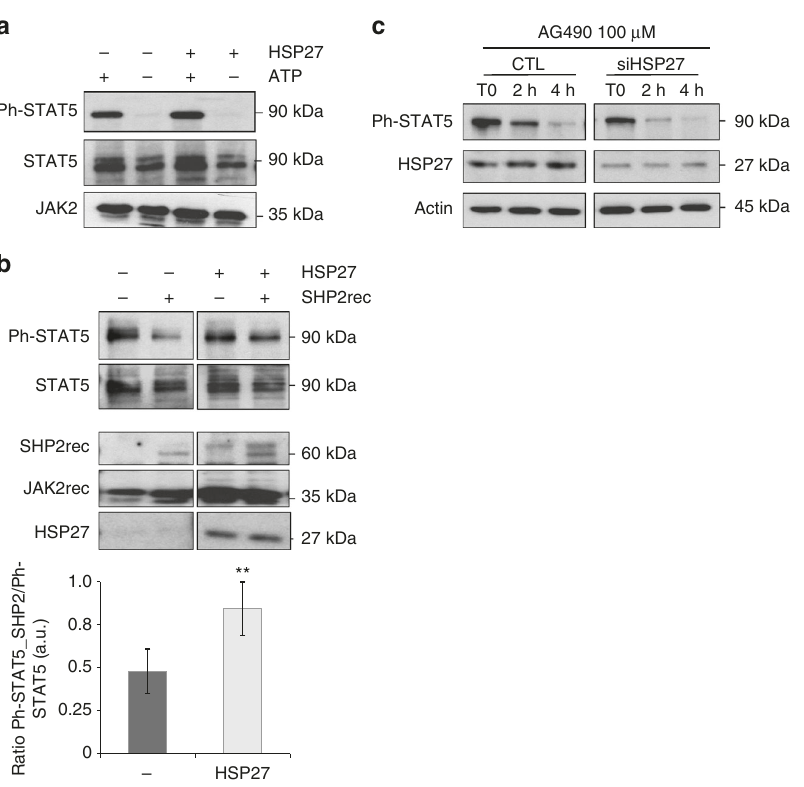
Fig. 4 HSP27 affects de-phosphorylation of STAT5. a The phosphorylation of STAT5 by JAK2 is HSP27 independent. An in vitro kinase assay was performed using the recombinant protein JAK2 and STAT5 (produced in reticulocyte lysate) in the presence or absence of HSP27 (produced in reticulocyte lysate). The level of STAT5 phosphorylation, and the amount of JAK2 and STAT5 proteins were determined by western blot ( n = 3 independent experiments). Uncropped blots presented in Supplementary Fig. 8a. b HSP27 impairs the in vitro de-phosphorylation of STAT5 induced by SHP2. Following an in vitro kinase assay using the recombinant protein JAK2 and STAT5 (same batch produced in reticulocyte lysate), samples were incubated or not with the recombinant phosphatase, SHP2, in the presence or absence of HSP27 (produced in reticulocyte lysate). The level of phosphorylated STAT5 was detected by western blot using an antibody speci fi c for Ph-STAT5. The expressions of JAK2, SHP2 and HSP27 are also shown. Bar graphs show normalized ratios of Ph-STAT5_SHP2/Ph-STAT5 bands quanti fi ed from the western blots ( n = 4 independent experiments), error bars represent the ±s.d. P values were calculated using the Student ’ s t test. ** P < .01. Uncropped blots presented in Supplementary Fig. 8b. c HEL92.1.7 cells were transfected with HSP27 siRNA or CTL for 48 h. Then, cells were treated or not with the JAK2 inhibitor, AG490 (100 μ M), at indicated times and lysed in Laemmli Buffer. Level of STAT5 phosphorylation was determined by western blot. Actin was used as the loading control ( n = 3 independent experiments). Uncropped blots presented in Supplementary Fig.